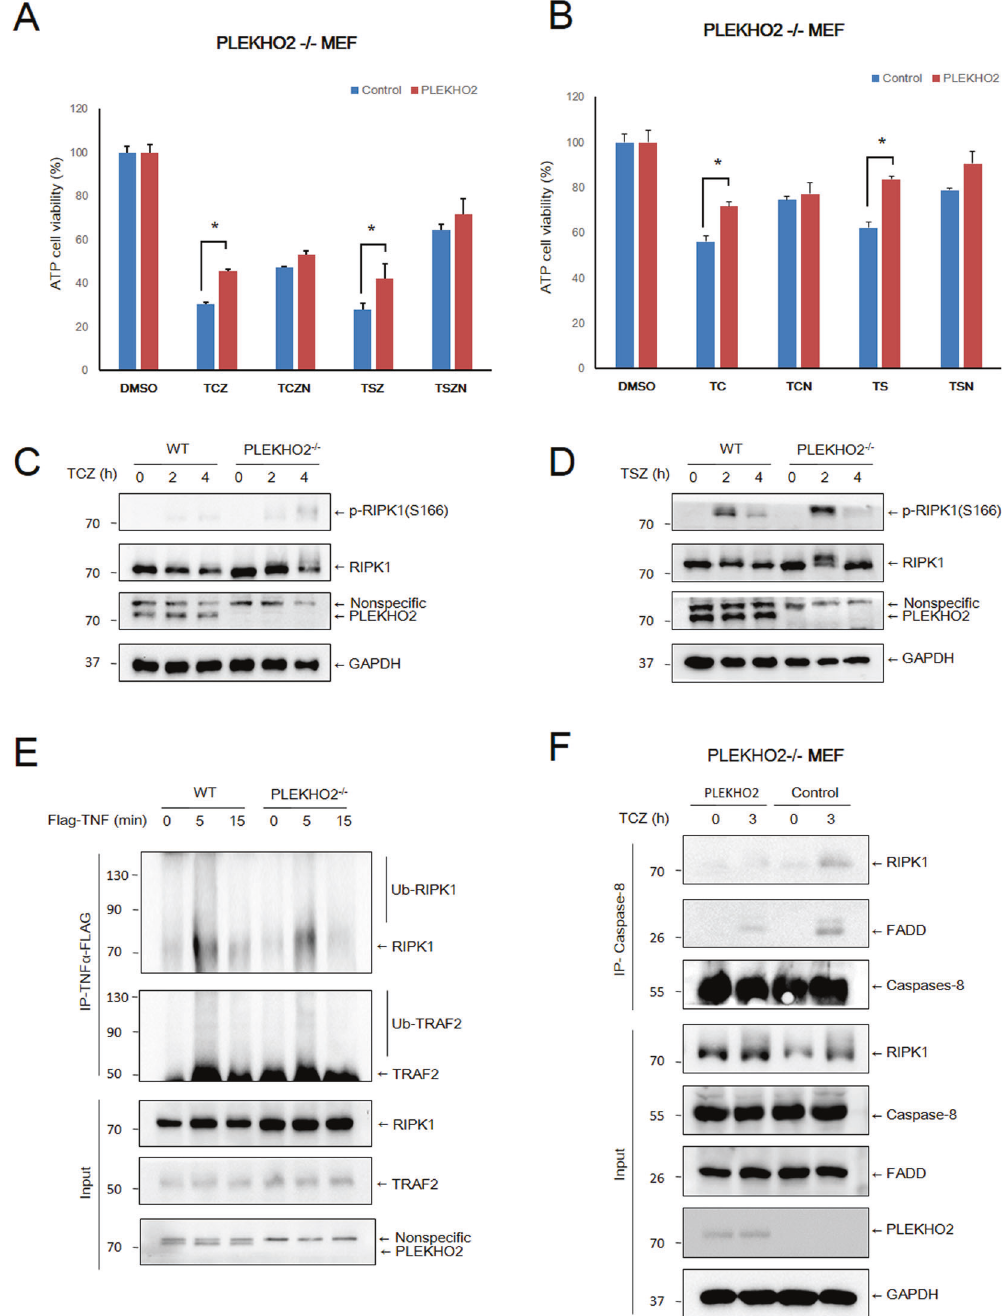
Fig. 3 PLEKHO2 de fi ciency facilitates necroptosis and activation of RIPK1. A Control and PLEKHO2 reexpressed PLKEHO2 − / − MEFs were treated with DMSO, TCZ, TCZN, TSZ, and TSZN for 8 h, cell viability was measured by ATP level. Abbreviations are as follows: TSZ TNF- α (20 ng/ ml) + Smac mimetic (100 nM) + zVAD (20 μ M), TSZN TNF- α + Smac mimetic + zVAD + Necrostatin-1 (20 μ M), TCZ TNF- α (20 ng/ml) + CHX (10 μ g/mL) + zVAD (20 μ M), TCZN TNF- α + CHX + zVAD + Necrostatin-1 (20 μ M). B Control and PLEKHO2 reexpressed PLKEHO2 − / − MEFs treated with DMSO, TS, TSN, TC, and TCN for 8 h, cell viability was measured by ATP level. Abbreviations are as follows: TS TNF- α (20 ng/ml) + Smac mimetic (100 nM), TSN TNF- α + Smac mimetic + Necrostatin-1 (20 μ M), TC TNF- α + CHX (20 ng/ml), TCN TNF- α + CHX + Necrostatin-1 (20 μ M). C WT and PLKEHO2 − / − MEFs were treated with TCZ, TCZ, TNF- α (20 ng/ml) + CHX (10 μ g/mL) + zVAD (20 μ M) for indicated periods of time. Cell lysates were probed with indicated antibodies. D WT and PLKEHO2 − / − MEFs treated with TSZ, TNF- α (20 ng/ml) + Smac mimetic (100 nM) + zVAD (20 μ M) for indicated periods of time. Cell lysates were probed with indicated antibodies. E WT and PLKEHO2 − / − MEFs were treated with Flag-TNF- α (100 ng/ml) for the indicated periods of time, complex I was immunoprecipitated using anti-FLAG beads, endogenous RIPK1 ubiquitination, and indicated proteins were detected by western blotting. F Control and PLEKHO2 reexpressed PLKEHO2 − / − MEFs were treated with TCZ, TCZ, TNF- α (20 ng/ml) + CHX (10 μ g/mL) + zVAD (20 μ M) for 3 h, and then Caspase-8 was immunoprecipitated (IP). IP and cell lysates were analyzed by western blotting using the indicated antibodies. Results are representative of at least three independent